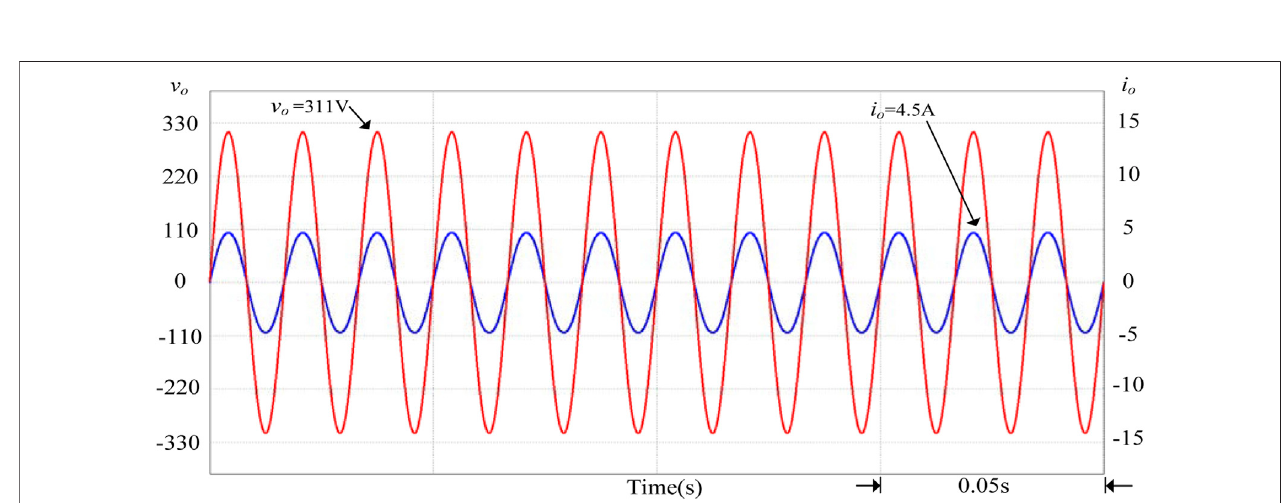
Frontiers in Energy Research |